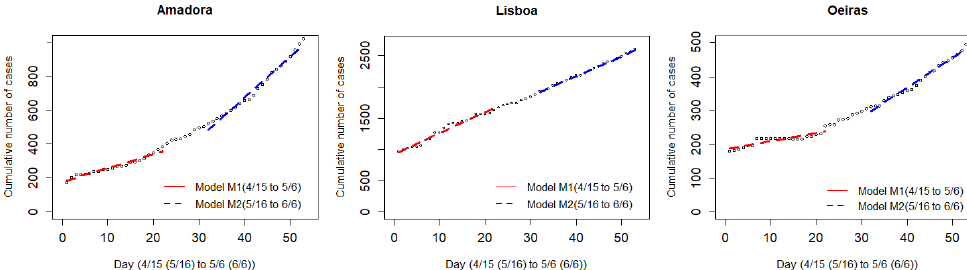
Figure 4. Linear models fit to the S 1 and S 3 periods (See Appendix A for all counties). S 1 is the period of M 1 model (red); S 3 is the period of M 2 model (blue).